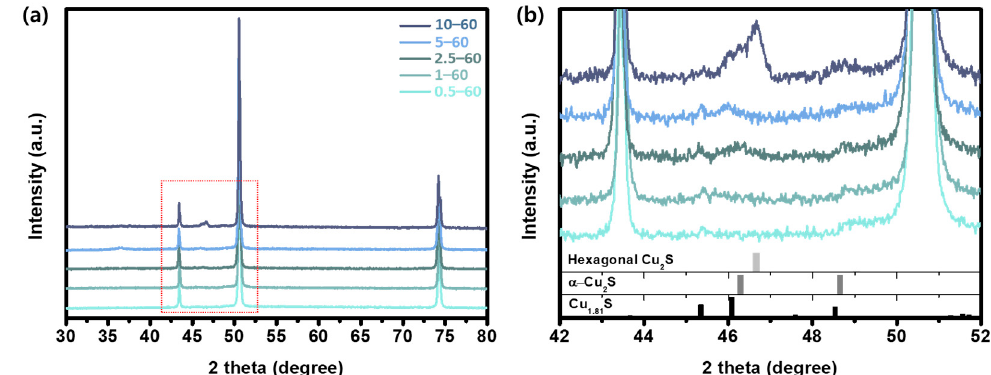
Figure 2. ( a ) XRD patterns of Cu films sulfurized with the reaction time of 60 min with varying Na 2 S solution concentrations (c = 0.5–10 mM) and ( b ) corresponding enlarged XRD patterns of 0.5–60, 1– 60, 2.5–60, 5–60, and 10–60 samples; the bars underneath correspond to the reference data for